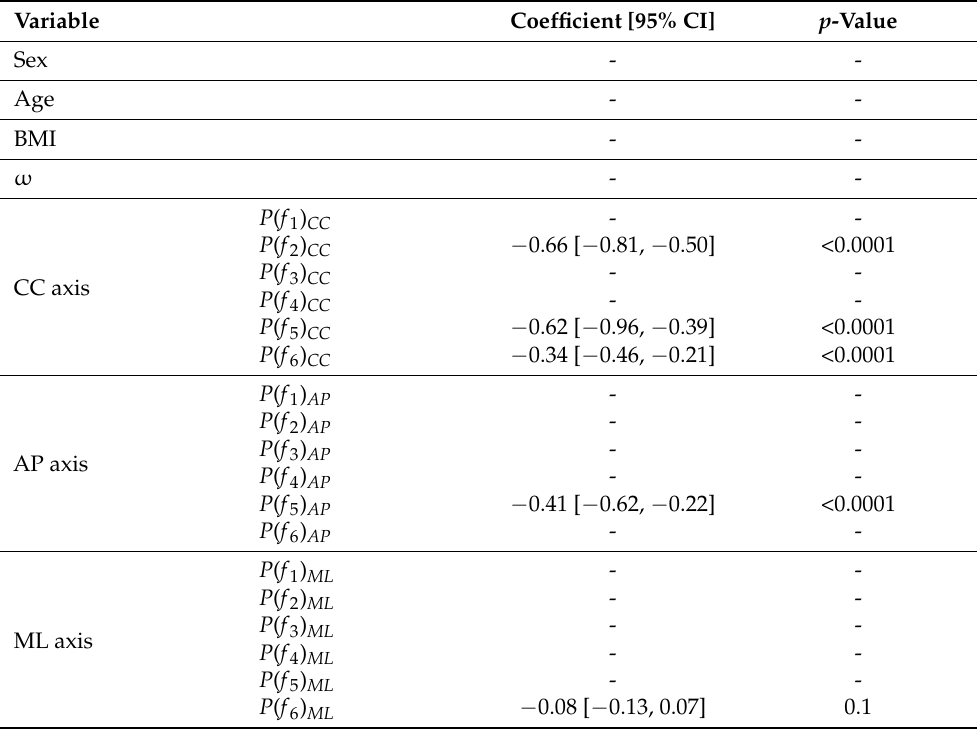
Table 4. The coefficients of the logistic LASSO regression at λ = λ 1se .